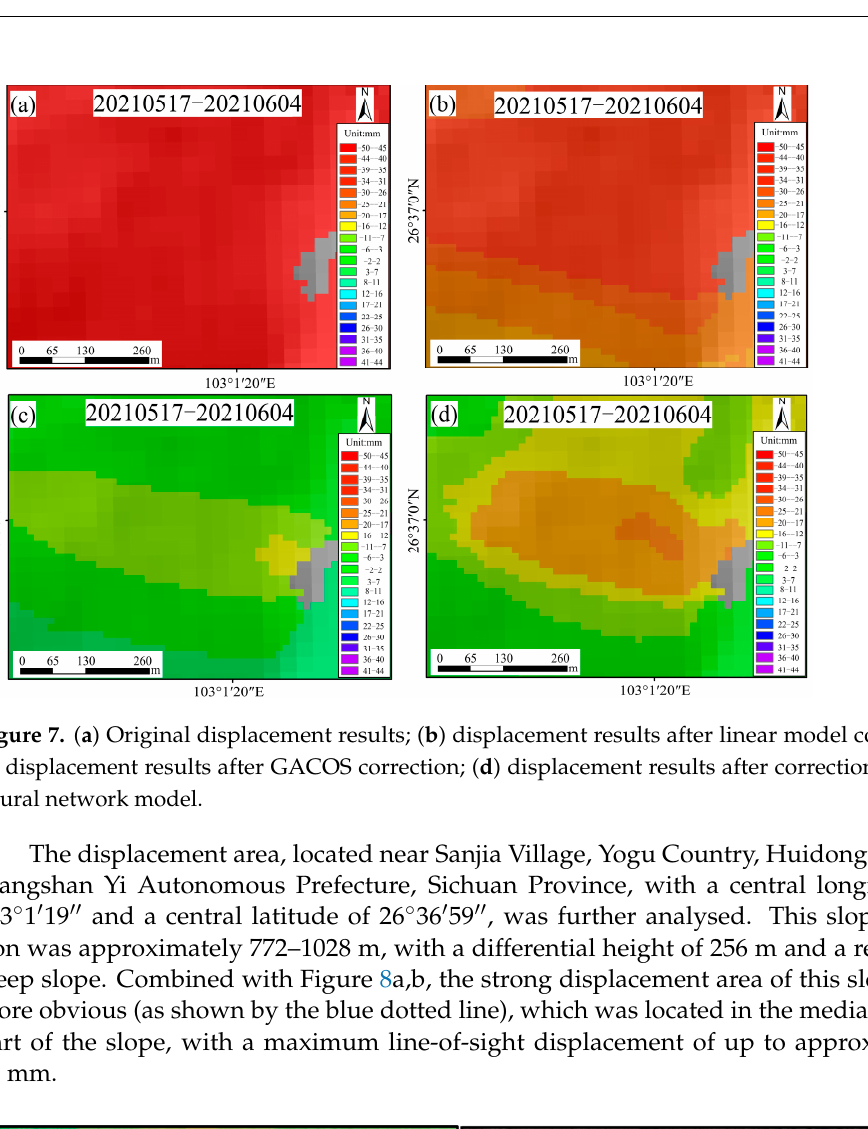
Figure 9. ( a ) Original displacement results; ( b ) displacement results after linear model correction; ( c ) displacement results after GACOS correction; ( d ) displacement results after correction of MLP neural network model. Figure 9a showed that the atmospheric delay effect seriously influenced the original displacement results, and the displacement location and displacement magnitude could not be accurately identified. The linear model correction was not effective, and the atmos- pheric phase remained serious after the correction (Figure 9b). From Figure 9c, it can be seen that the GACOS correction had a certain effect but failed to accurately identify the location of the landslide. Figure 9d reveals that the MLP neural network model had the optimal correction effect. Moreover, with the exception of the obvious displacement in the